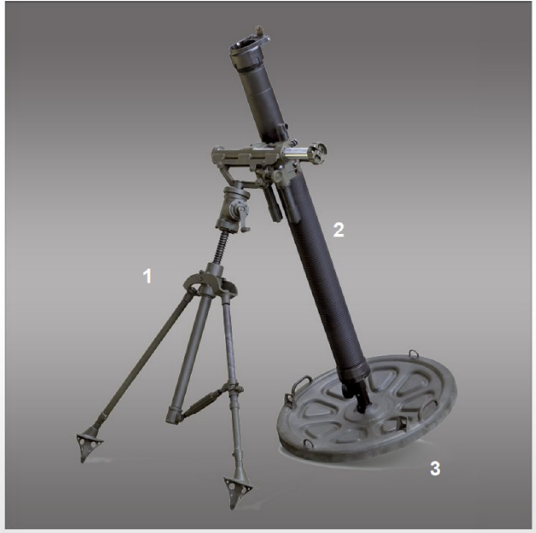
Figure 1. Mortar M98 (HSW S.A.), 1—bipod unit with elevation and direction mechanisms, 2—mortar tube, and 3—base plate.